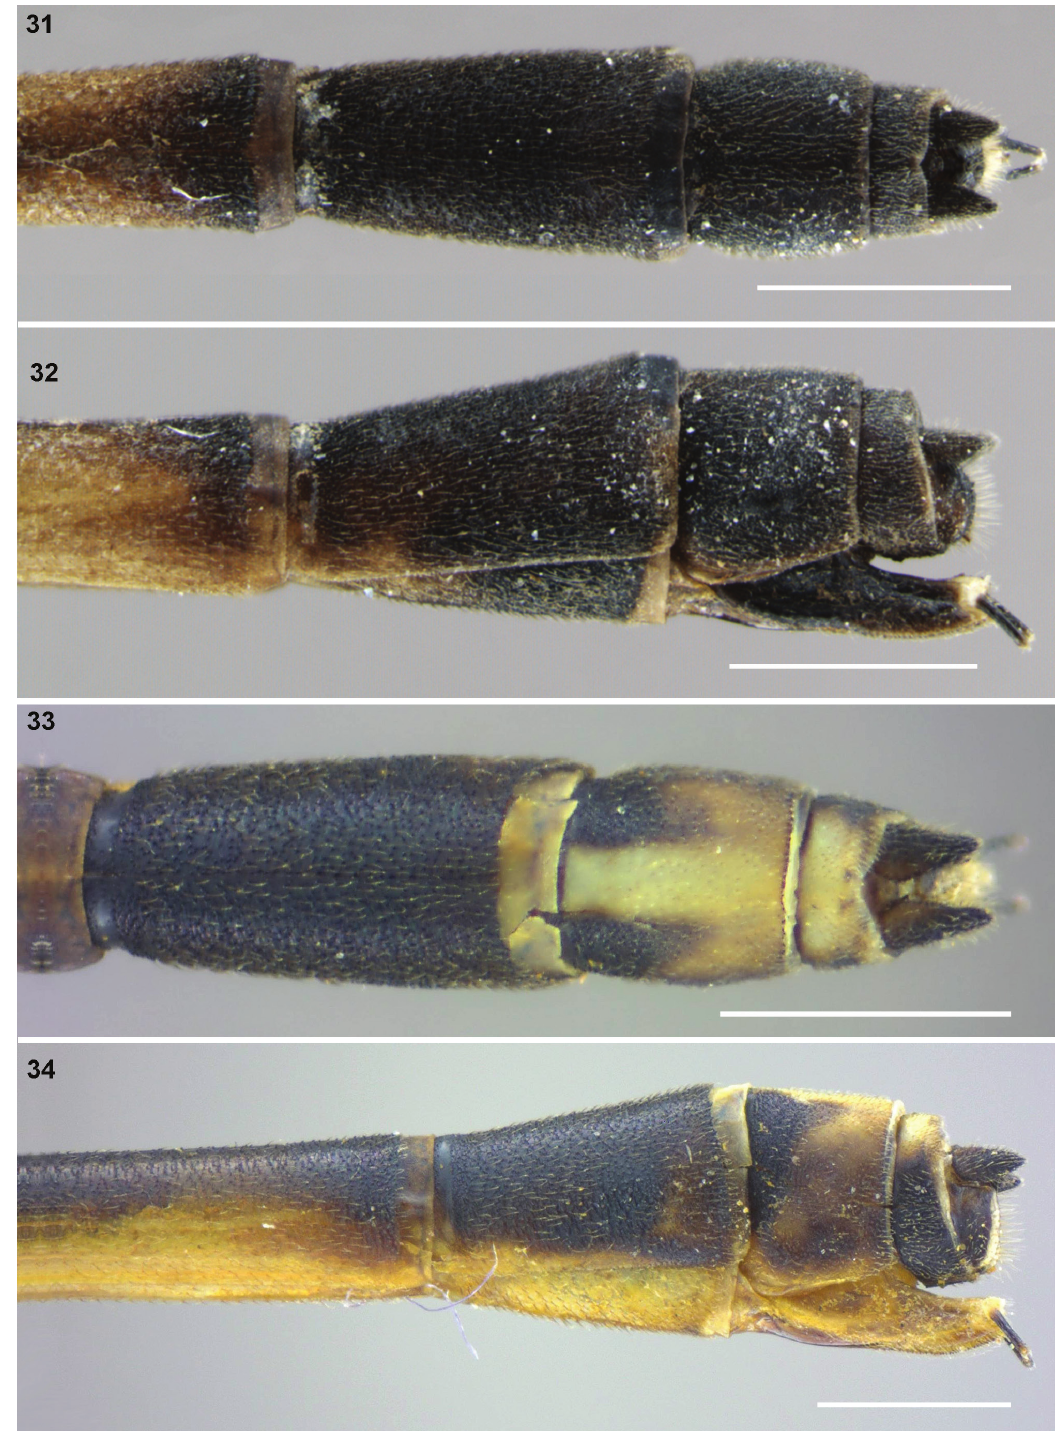
Figures 31–34. Abdominal segments seven to ten (S7–10) of females of Forcepsioneura : (31–32) F. regua sp. nov., paratype (Brazil. RJ: Cachoeiras de Macacu, DZRJ); (33–34) F. serrabonita sp. nov., paratype (Brazil. BA: Camacan, MNRJ ODO-0001). Scale bars for Figs 31–32 =